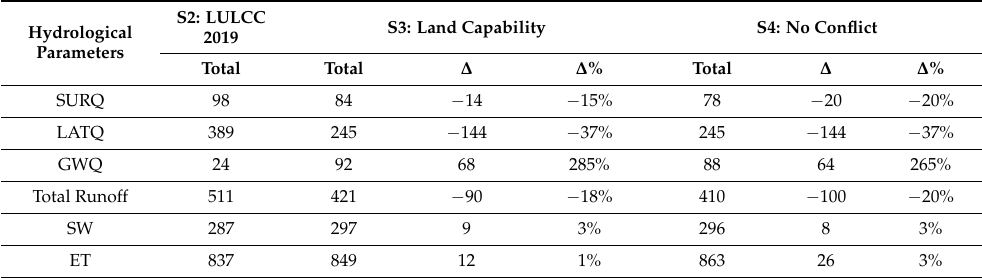
Table 12. Comparison of the Water Balance of the S2: LULCC 2019 with S3: Land Capability and S4: No